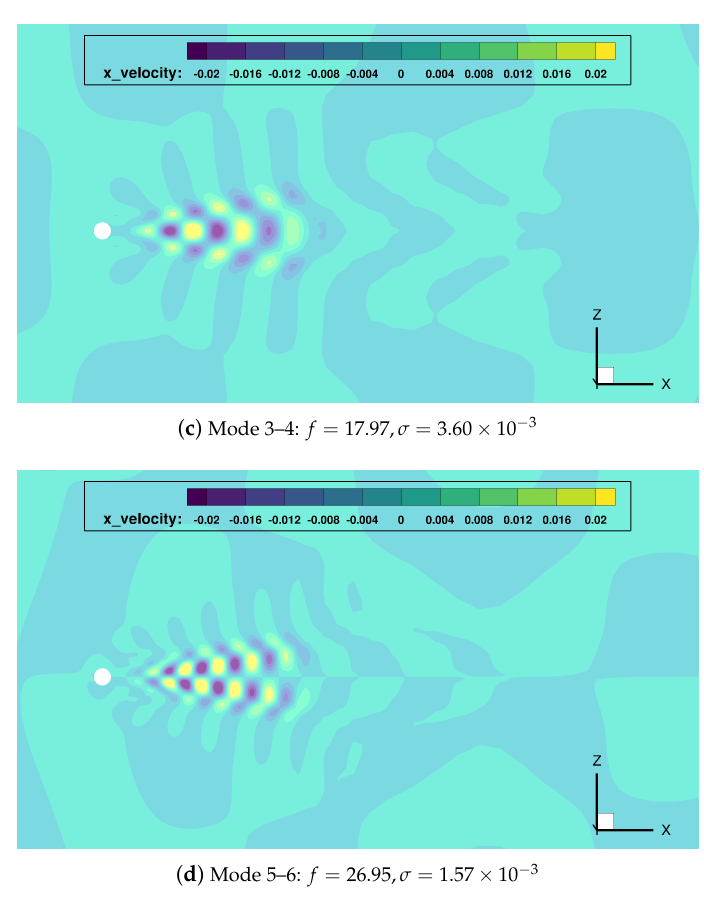
Figure 8. Re D = 60 cylinder flow: most relevant DMD modes, and corresponding frequencies and growth